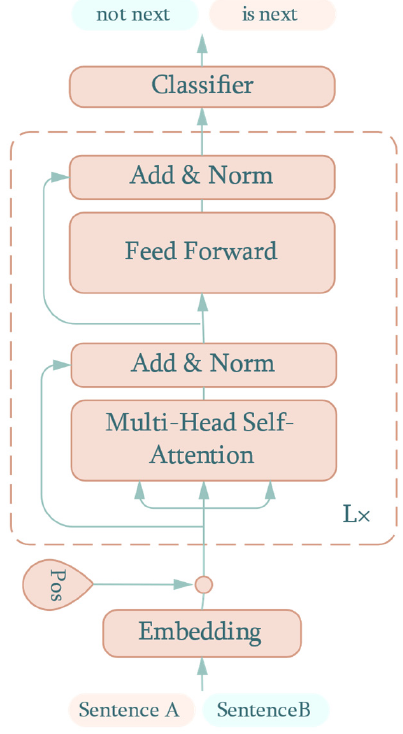
Figure 1. BERT structure for next sentence prediction.